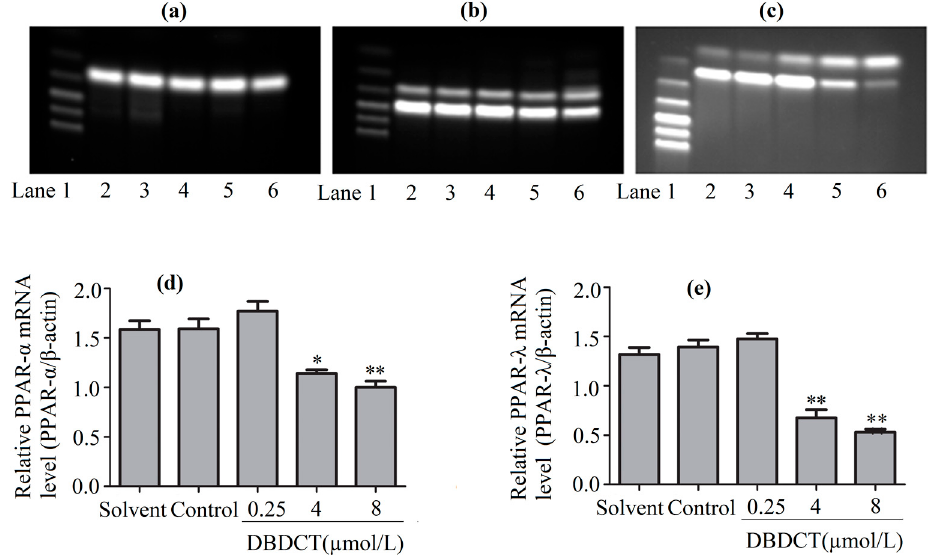
Figure 7. The PPAR- α and PPAR- λ expression levels of mRNA in BRL cells with the treatment of DBDCT (0.25, 4, and 8 µ mol/L). ( a – c ) The RT-PCR results of β -actin, PPAR- α and PPAR- λ ; ( d , e ) Relative mRNAs level of PPAR- α and PPAR- λ in BRL cells. Lane 1: Marker; Lane 2: Solvent; Lane 3: Control; Lane 4: 0.25 µ mol/L for 24 h; Lane 5: 4 µ mol/L for 24 h; and Lane 6: 8 µ mol/L for 24 h. The results are expressed as a ratio of the expression levels of the reference mRNA of β -actin (* p < 0.05; ** p < 0.01; compared with control group).